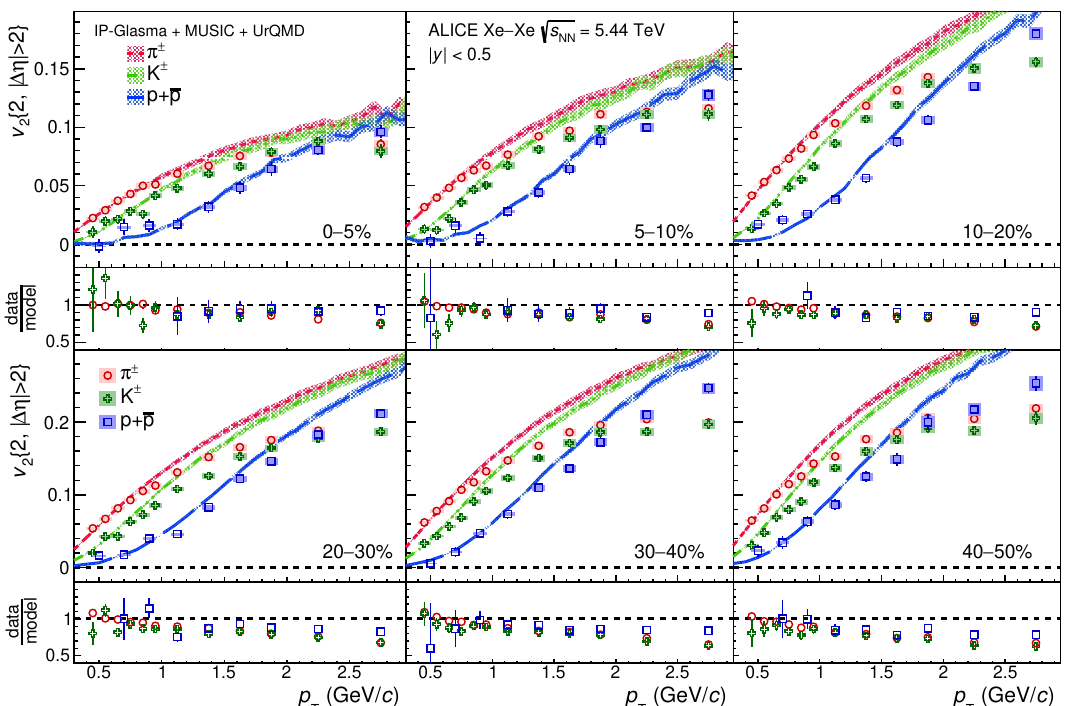
Figure 11. The p T -differential v 2 of π ± , K ± , and p+ p for various centrality classes compared to hydrodynamic calculations from MUSIC model using IP-Glasma initial conditions (colored curves) [67]. Bars (boxes) denote statistical (systematic) uncertainties. The uncertainties of the hydrodynamic calculations are depicted by the thickness of the curves. The ratios of the measured v 2 to a fit to the hydrodynamic calculations are also presented for